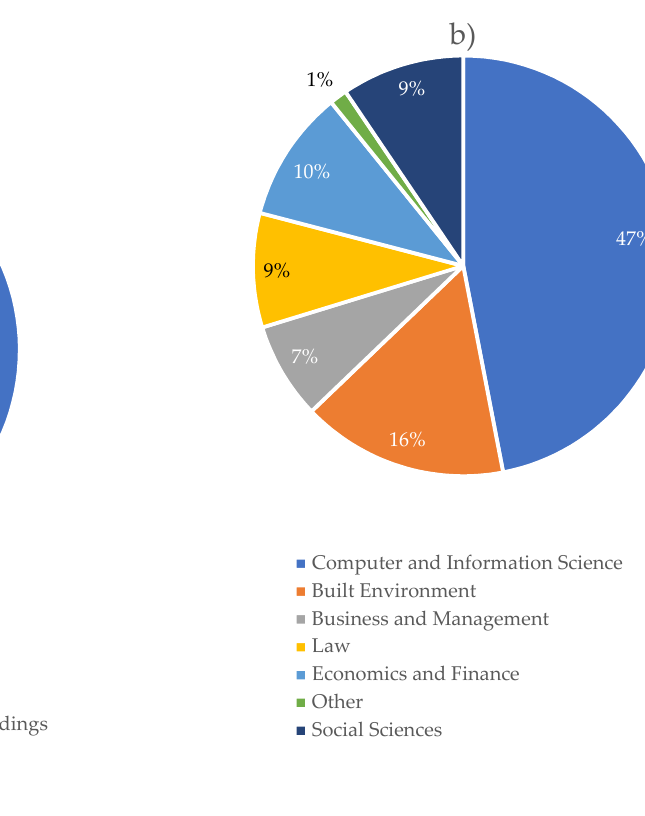
Figure 3. Literature by ( a ) publication types and ( b ) publishing fields. Table 1. Literature’s ten most-often-used author